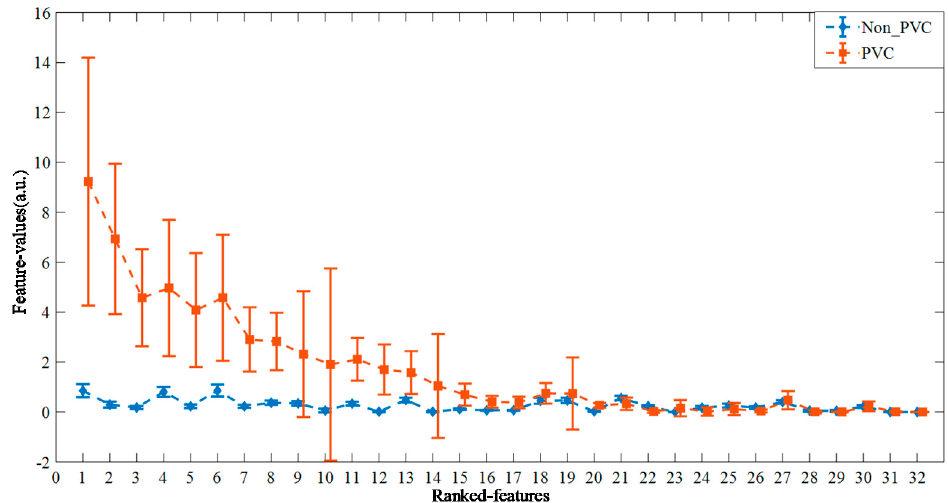
Figure 3. The ranked feature vectors of PVC and Non_PVC from record 228, according to the t -test p -value in ascending order.